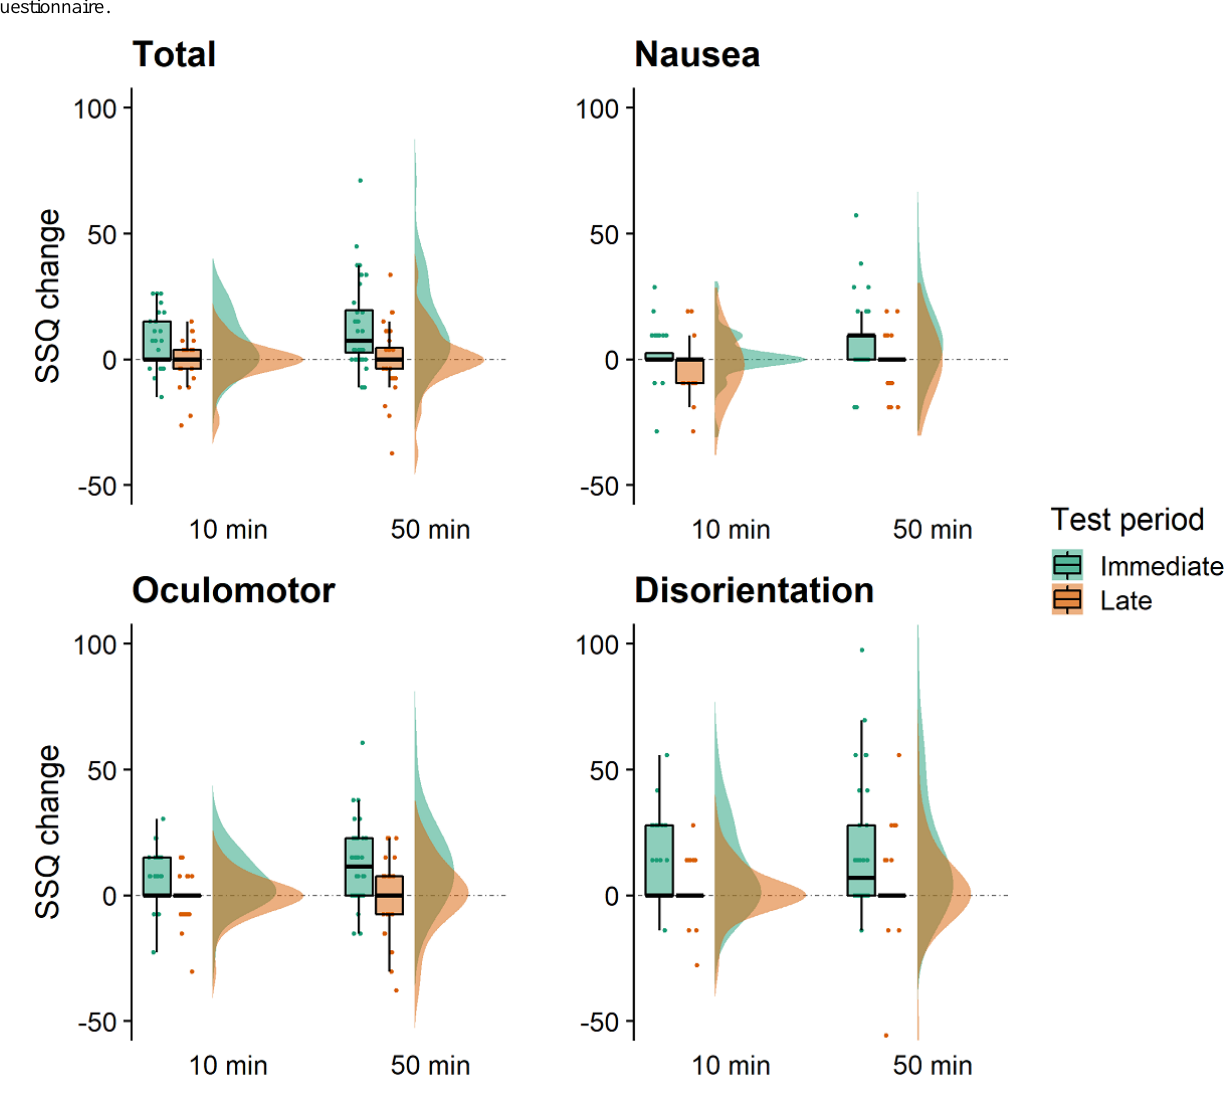
Figure 5. Raincloud plots for the total Simulator Sickness Questionnaire and subscale difference scores showing test periods and exposure duration. Positive and negative scores, respectively, indicate an increase and decrease in sickness symptoms compared with baseline. SSQ: Simulator Sickness